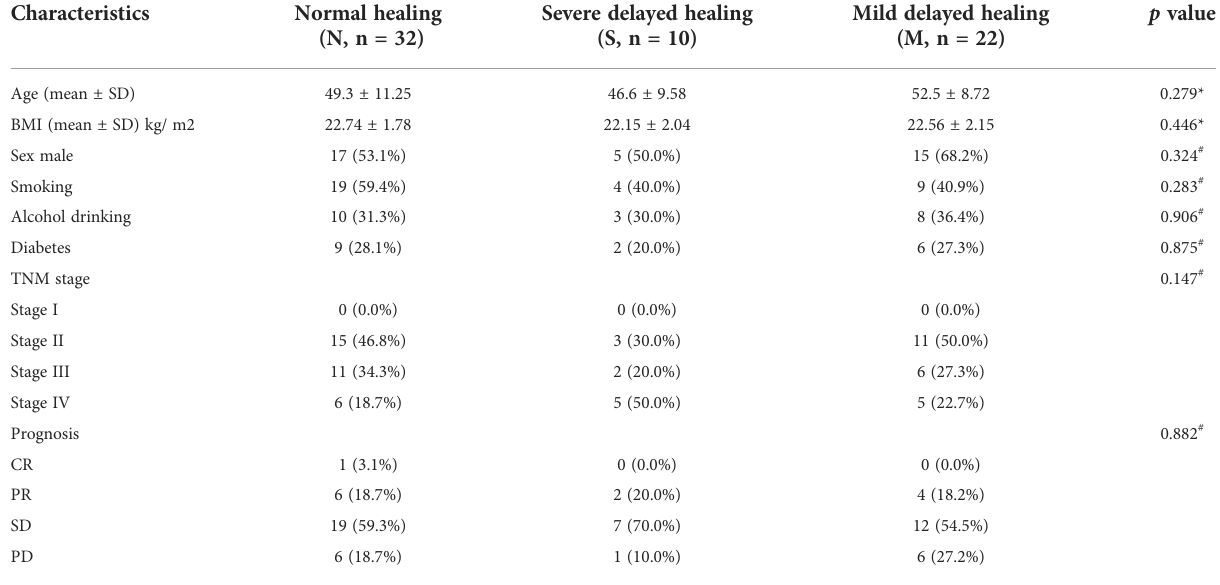
TABLE 1 Clinical characteristics of the enrolled participants.